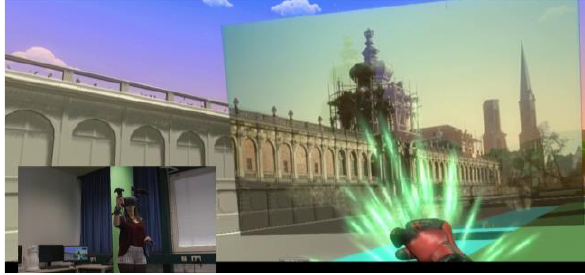
Figure 7 . Re-photography of historical photos in